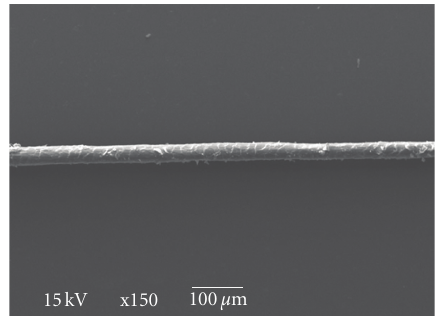
Figure 1: Marino wool fiber ( × 150).